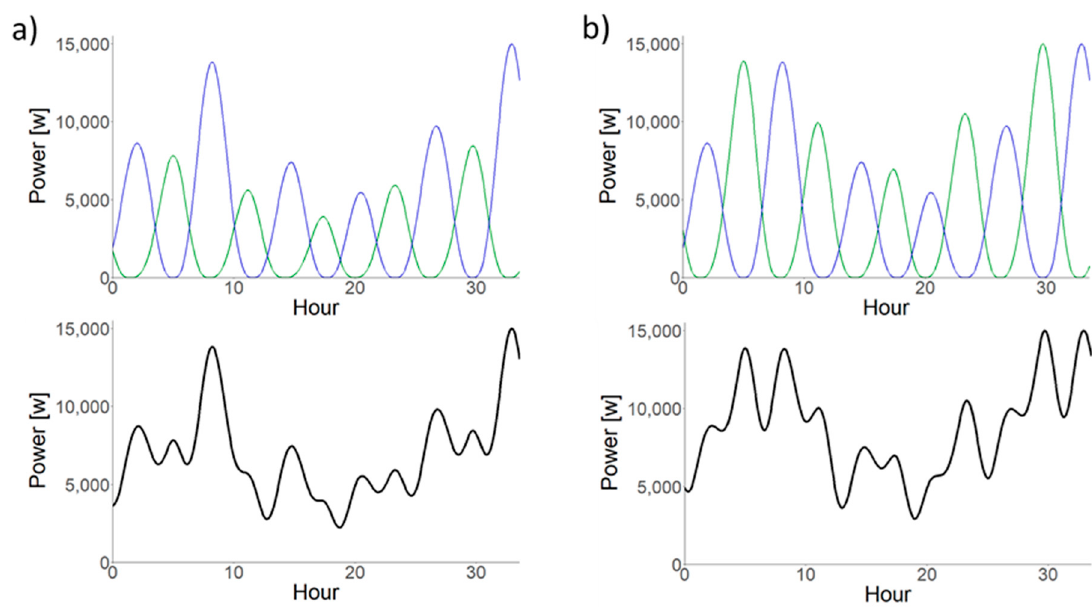
Figure 6. Power ( a ) and scaled power ( b ) at Cook Inlet Point 6 (green) and Point 8 (blue) above the aggregate power density of the two locations.